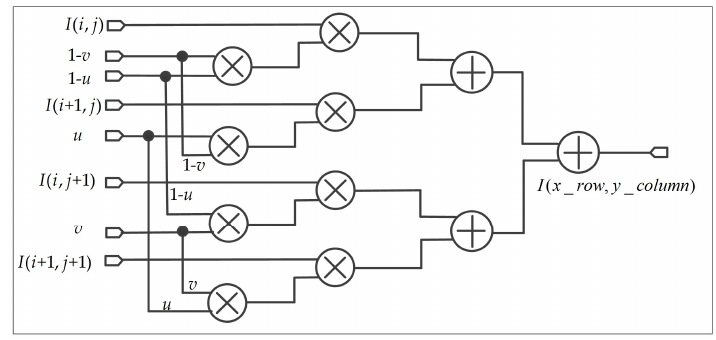
Figure 19. The parallel computation for bilinear interpolation